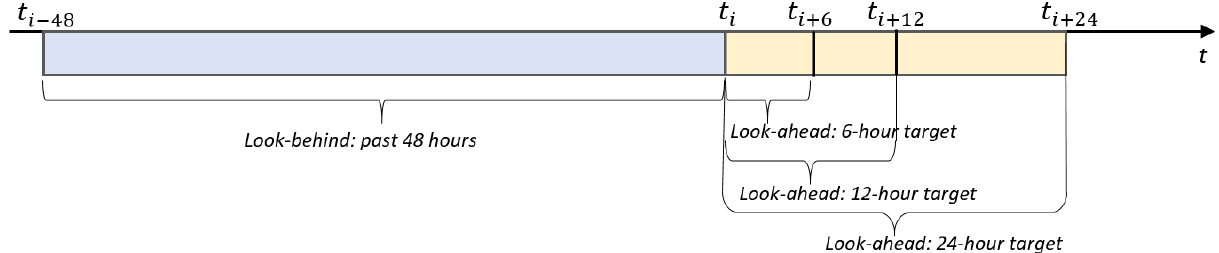
Figure 10: Rolling time window for generating instances for training and